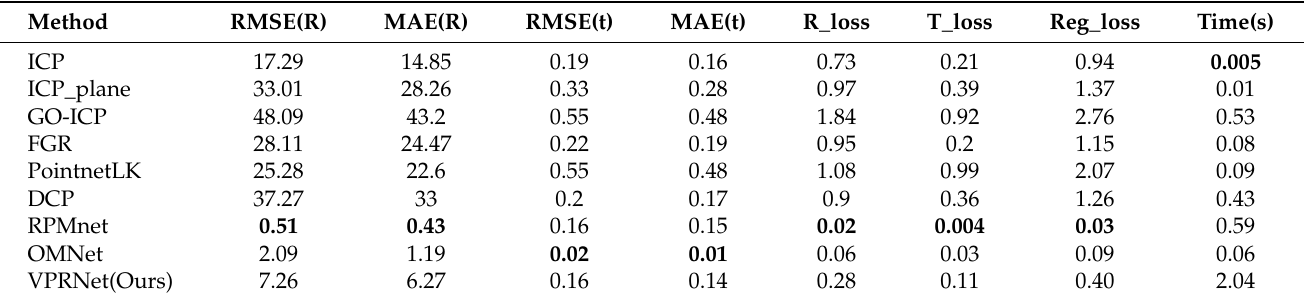
Table 2. Results on point clouds of unseen categories in ModelNet40. Bold numbers are the smallest in the current column, and represent the best performance. Lower is better.